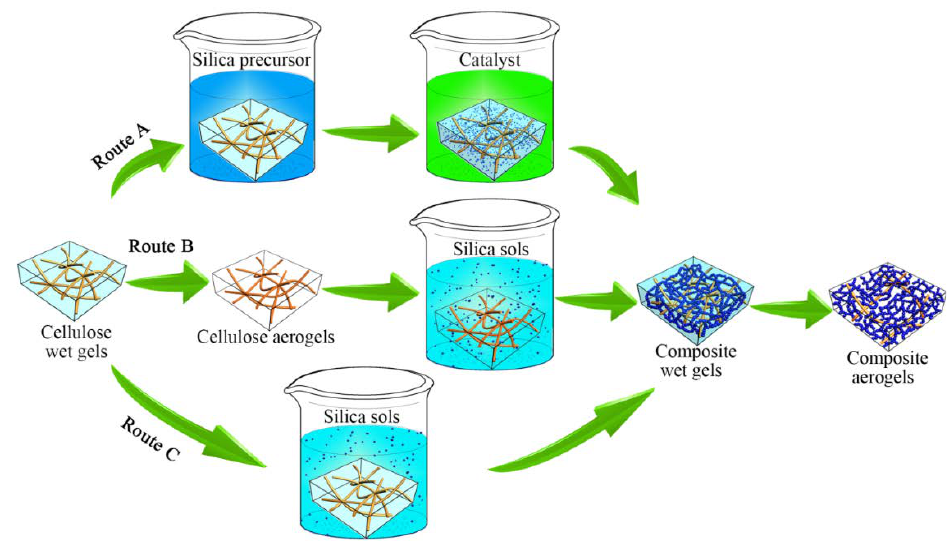
Figure 1. Schematic of the preparation process for composite aerogels with a nanoscale interpenetrating network (IPN) structure via three different routes.